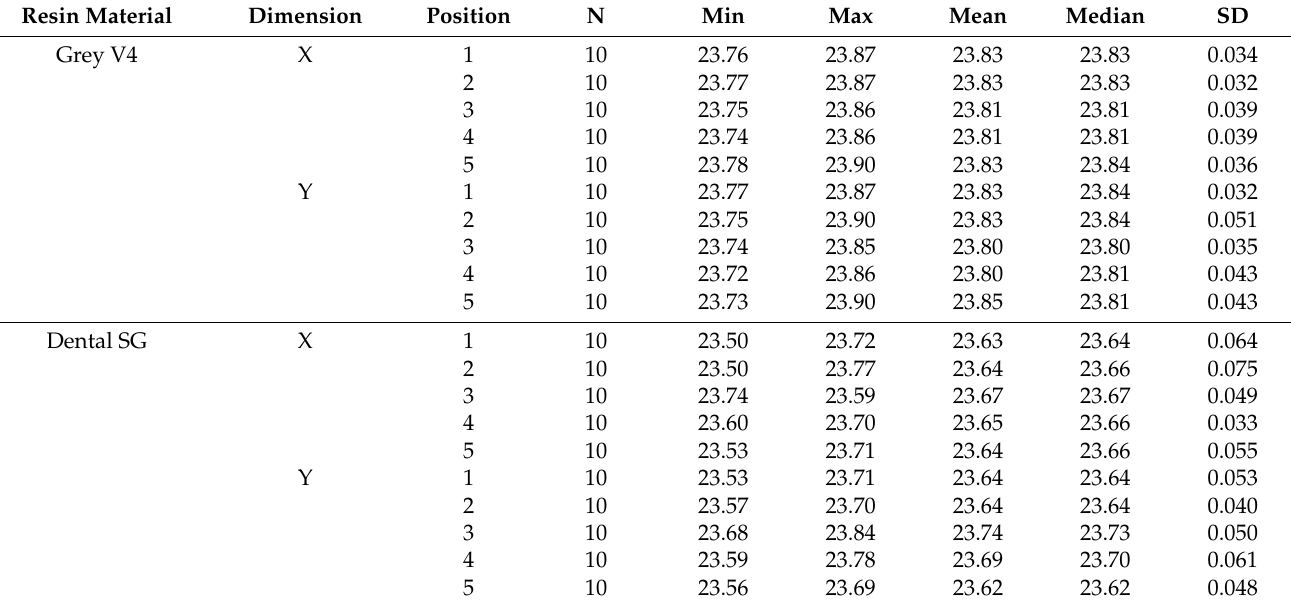
Table 3. Descriptive statistics of positions for Dental SG and Grey V4 resins at.